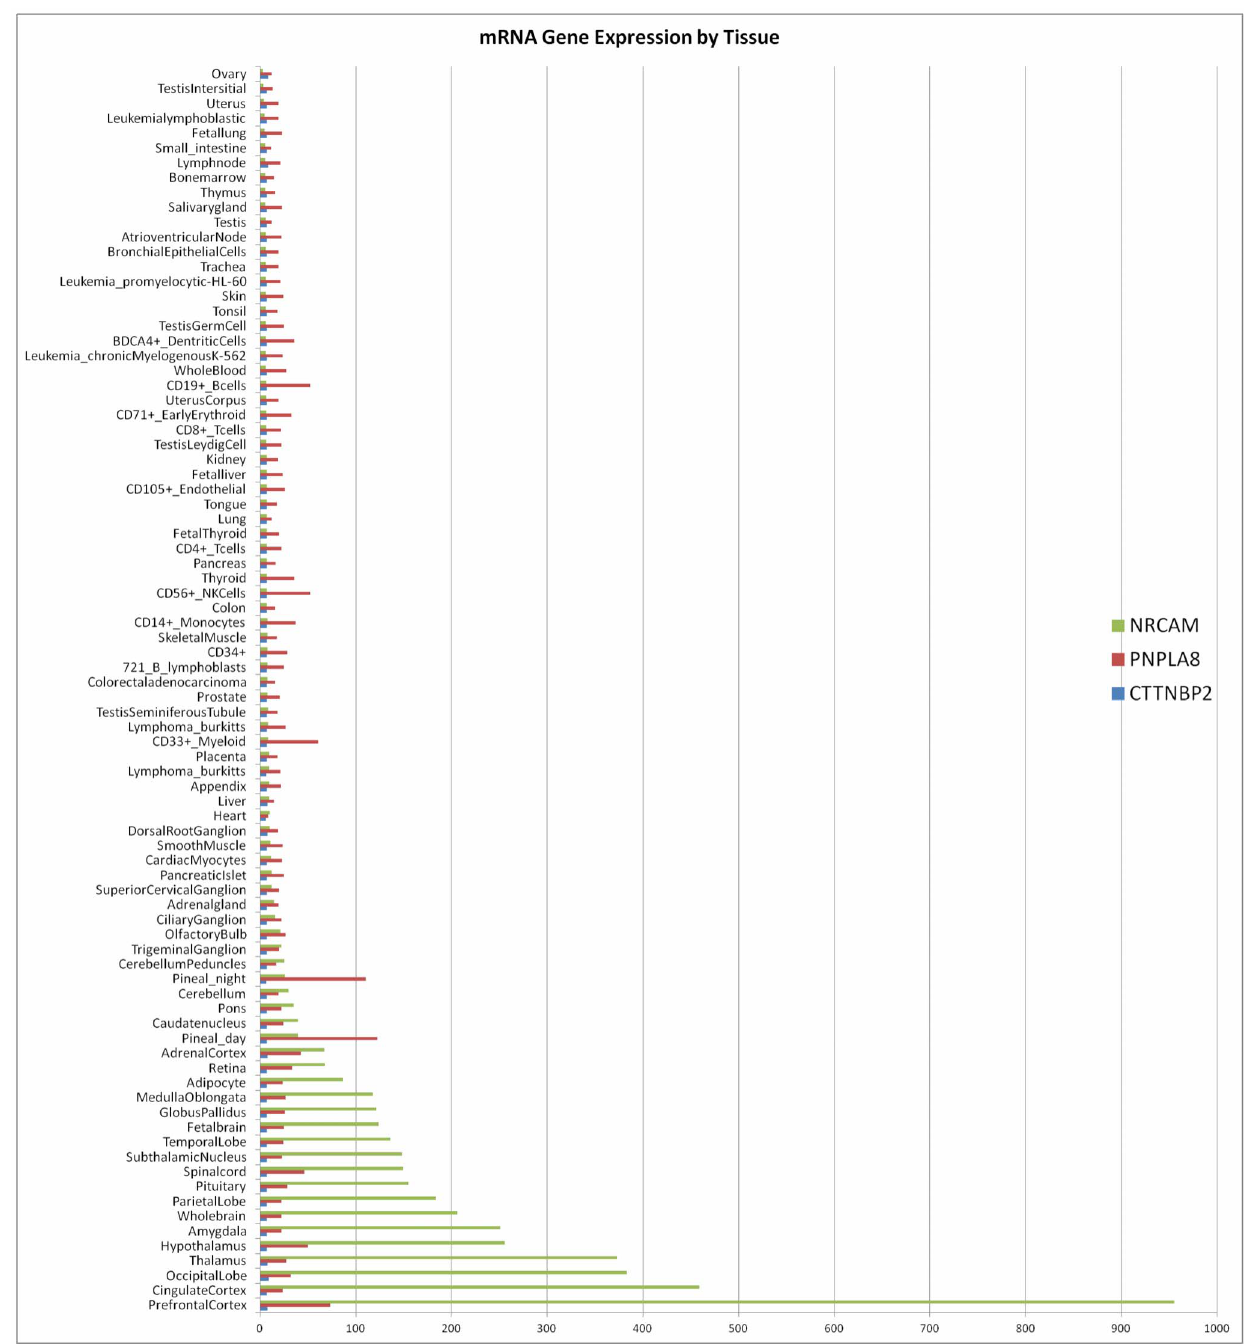
Figure 2. mRNA expression levels of NRCAM, PNPLA8, CTTNBP2. Graph created using data from www.biogps.org (accessed 7/18/2012) for mRNA expression levels of the gene’s mRNA expression across 84 mouse and humans tissues. While few gene expression across multiple tissues have been done in bovine, it is logical to expect a similar expression pattern as shown above given the high gene exon homology of PNPLA8, CTTNBP2, and NRCAM between bovine, mouse, human, and other mammalian species